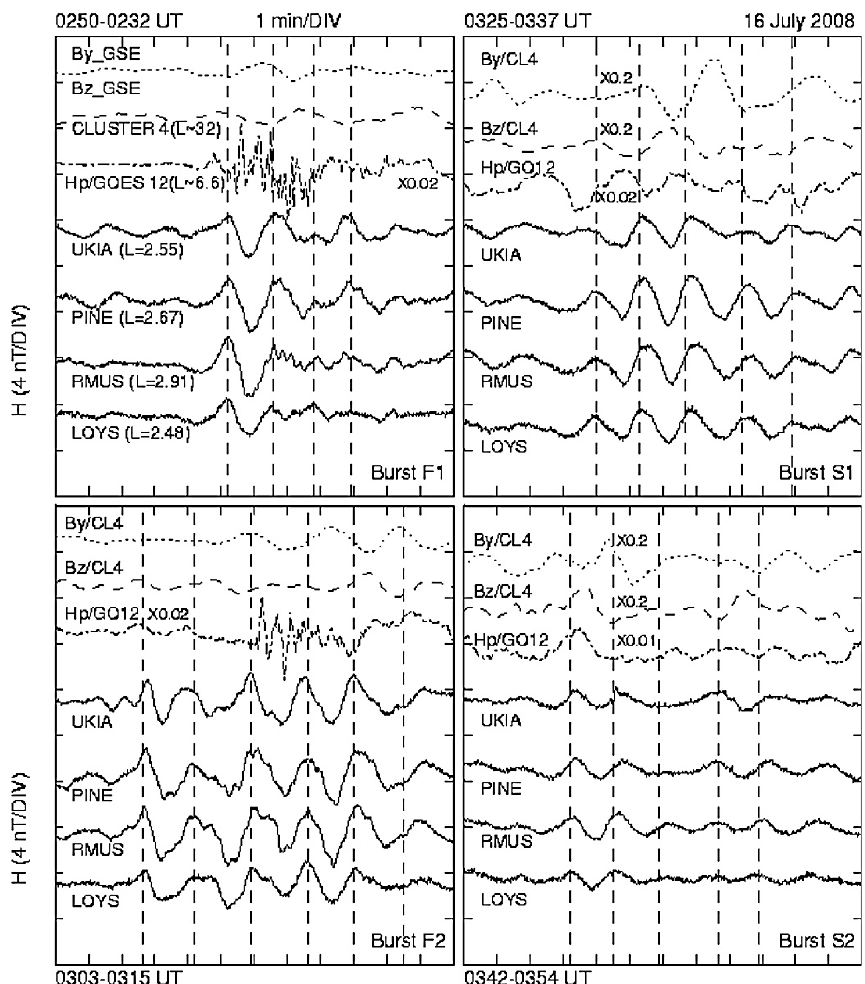
Fig. 17. Waveforms for the low L stations. Comments of caption to Fig. 15